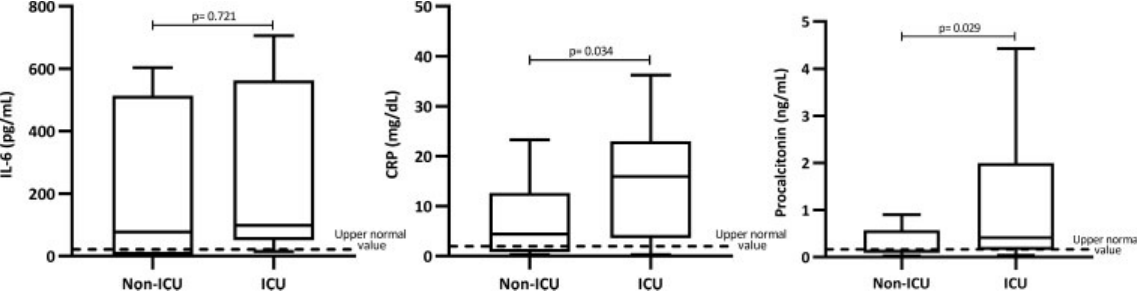
Fig. 4 In fl ammatory biomarkers in non-ICU and ICU